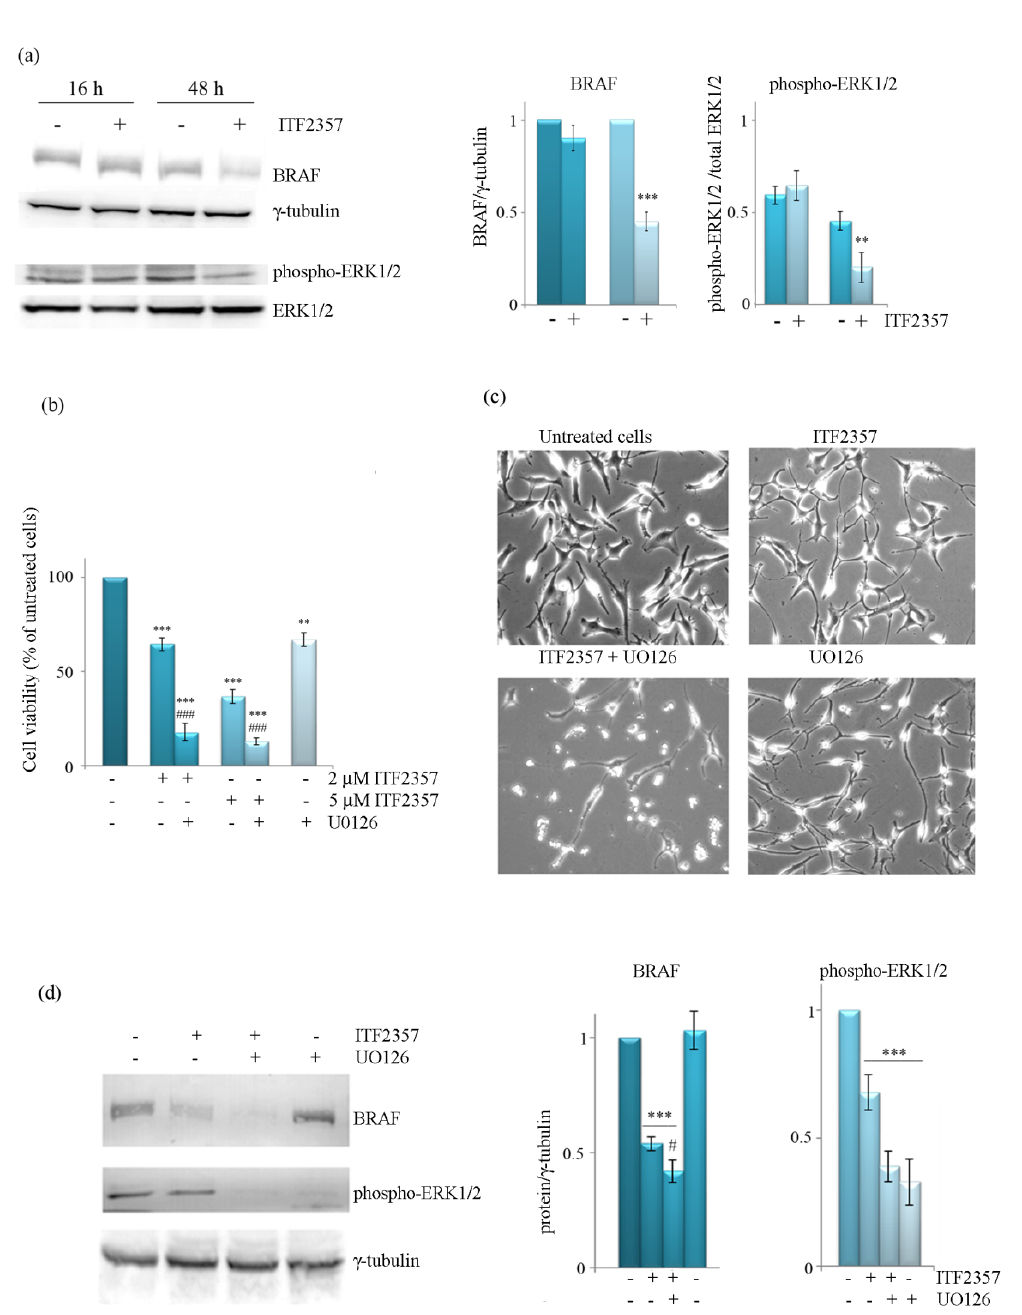
Figure 5. The effects of ITF2357 on phospho-ERK1/2 and potentiation by the MEK inhibitor U0126. ( a ) Western blot analysis of BRAF and phospho-ERK1/2 after 16 and 48 h treatment of SK-MEL-28 cells with 5 µM ITF2357. The effects of ITF2357 in the presence of U0126 on cell viability ( b ) and cell morphology ( c ). Cells were treated with ITF2357 at the indicated concentrations in the absence or presence of U0126 (10 µM) for 48 h. Cell viability was then assessed by MTT assay as reported in Materials and Methods. For morphological analysis, cells were treated for 24 h with 5 µM ITF2357 in the absence or presence of 10 µM U0126. The cells were visualized under light microscope at 200× magnification and the pictures acquired by IM50 Leica Software (Leika Microsystems, Wetzlar, Germany). ( d ) Western blot analysis of BRAF and phospho-ERK1/2 following ITF2357 treatment for 48 h in the absence or presence of U0126. Representative blots of three independent experiments and densitometric analysis are shown. ** p < 0.01, *** p < 0.001 with respect to untreated cells, # p < 0.05, ### p < 0.001 with respect to ITF2357 treated cells.